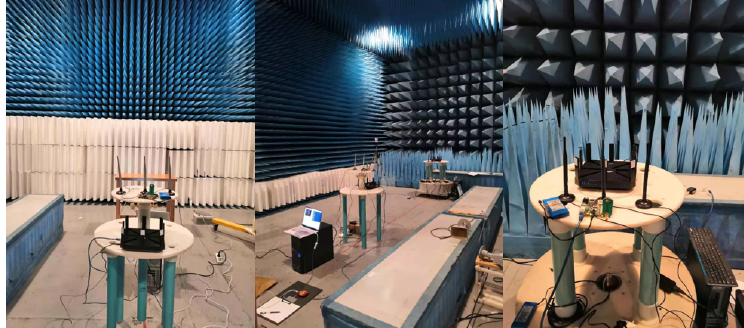
Figure 3. Data collection experimental scene in the anechoic chamber.